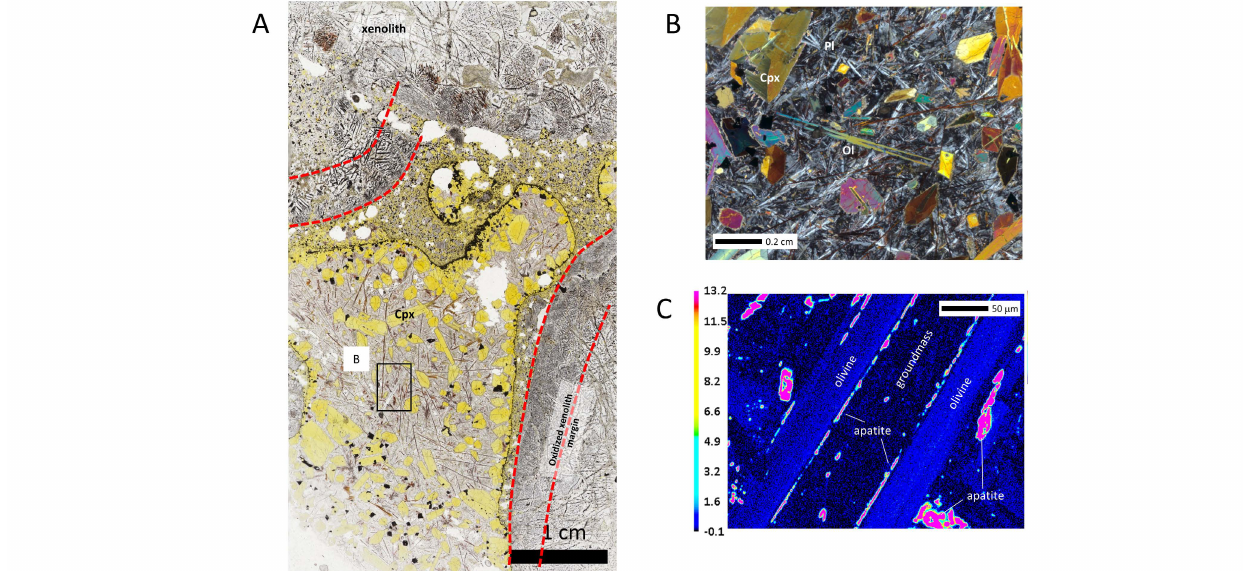
Figure 2: Case study of dendritic olivine from Kaua ‘ i, Hawai ‘ i. [A] Plane transmitted light image of cumulate peridotite xenolith (top half and lower right) encased in host alkali basalt (lower left corner). Xenolith consists of olivine grains from which Fe 3+ - oxides (ferrite) have exsolved (black minerals). Oxidized margins of xenolith show more exsolution of ferrite and appear darker. Host lava consists of olivine, clinopyroxene (Cpx) and feldspar matrix along with elongated crystals of clinopyroxene (light yellow colors). Rectangle labeled “B” represents zoomed in area in B. [B] Close up of lava groundmass in crossed polarized transmitted light (see rectangle in A). Long, swallow-tailed grain in center is a dendritic olivine (Ol) that was analyzed in detail in this study. Cpx = clinopyroxene. [C] Electron probe micro-analysis WDS map of P for the dendritic olivine in B. Dendritic olivine is blue. Red areas represent apatite, a P-bearing accessory phase. Tip of olivine dendrite needle is towards the lower left. Scale bar represents P O in wt. %. 2 5